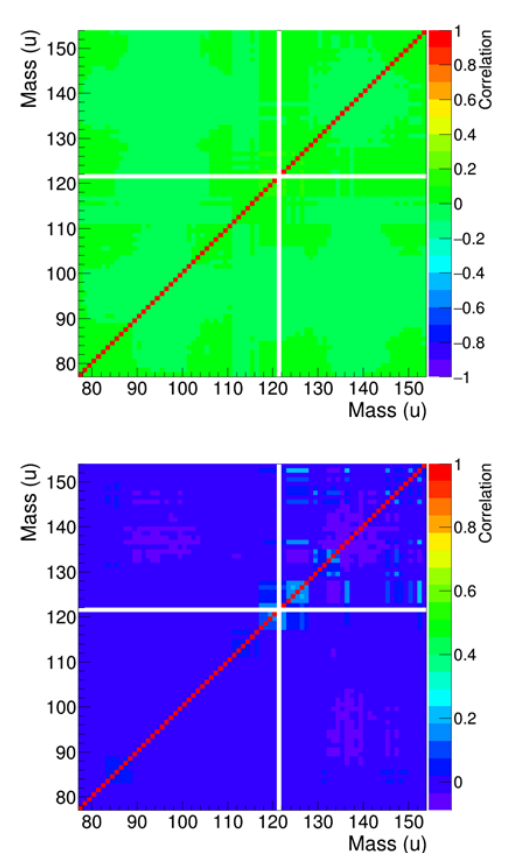
Fig. 11. (top) Mass yield correlations from of 235 U(n th ,f) [15] (bottom) zoom on the structures, principally on the heavy mass region.